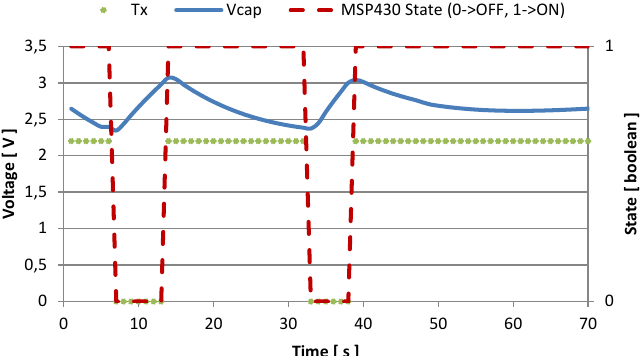
= 1.7 GHz, and CLK